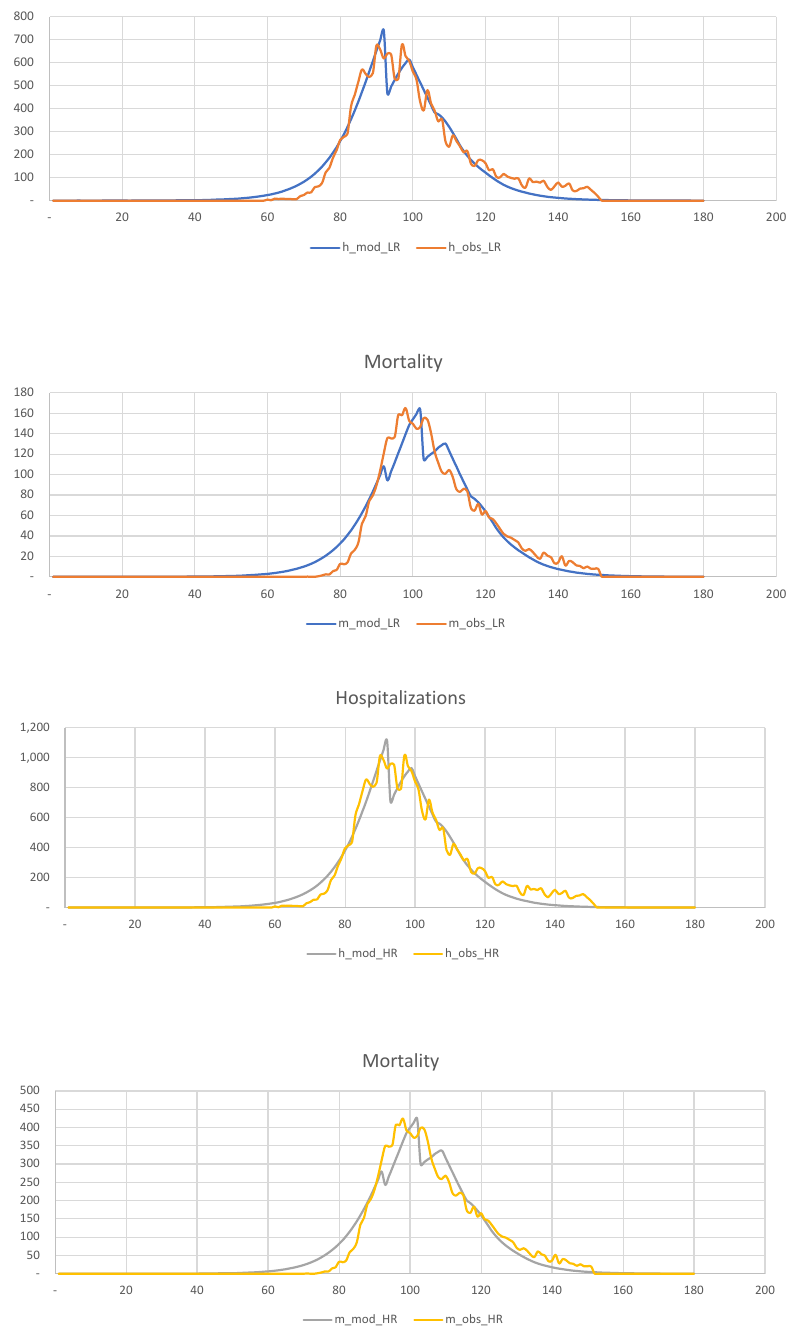
Figure 19. Calibration of the 2-SEIR model to the hospitalization and death statistics in NYC for the LR and HR